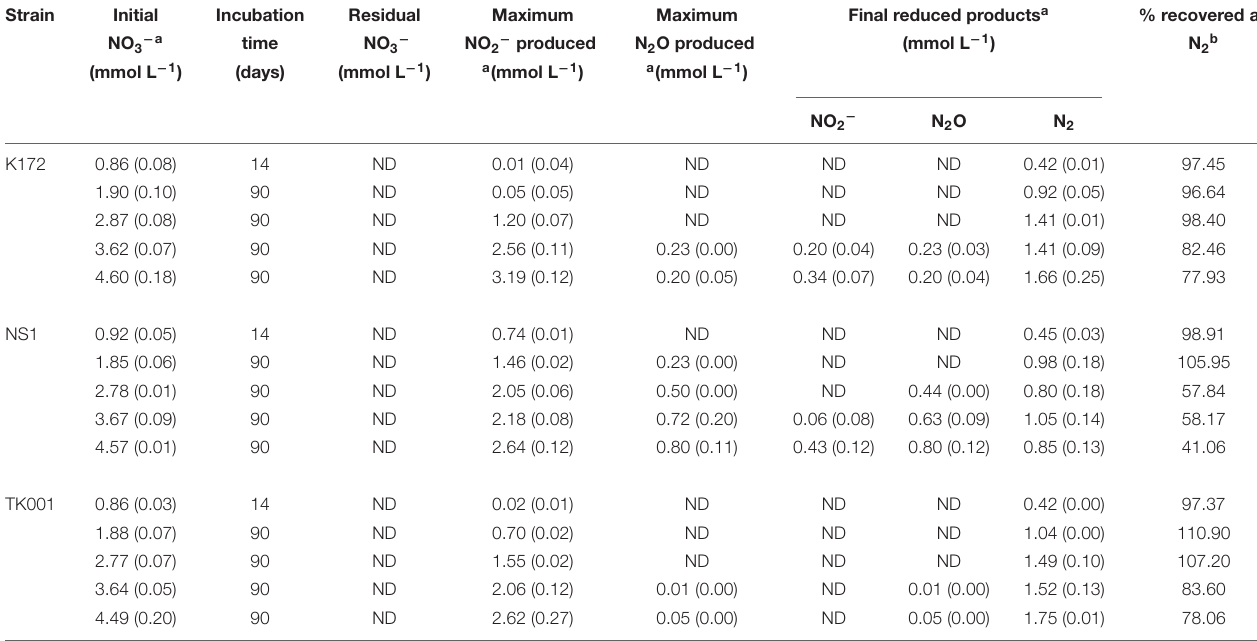
TABLE 5 | Production and distribution of reduced products of denitrification coupled to acetate oxidation in batch cultures of Thauera strains amended with different NO 3 −